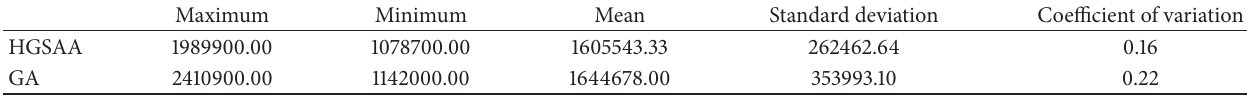
Table 2: Statistical results of optimal objective function value of two algorithms.